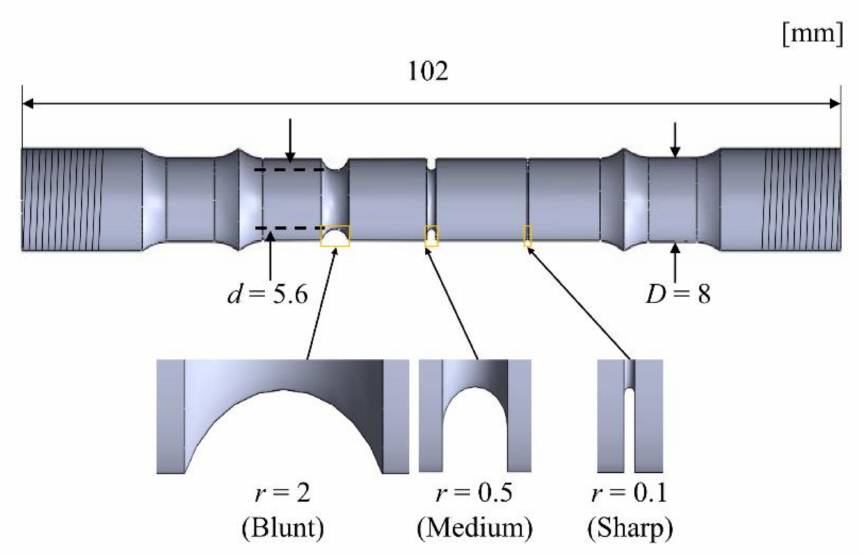
Figure 2. Dimensions of the notched bar specimen with three different